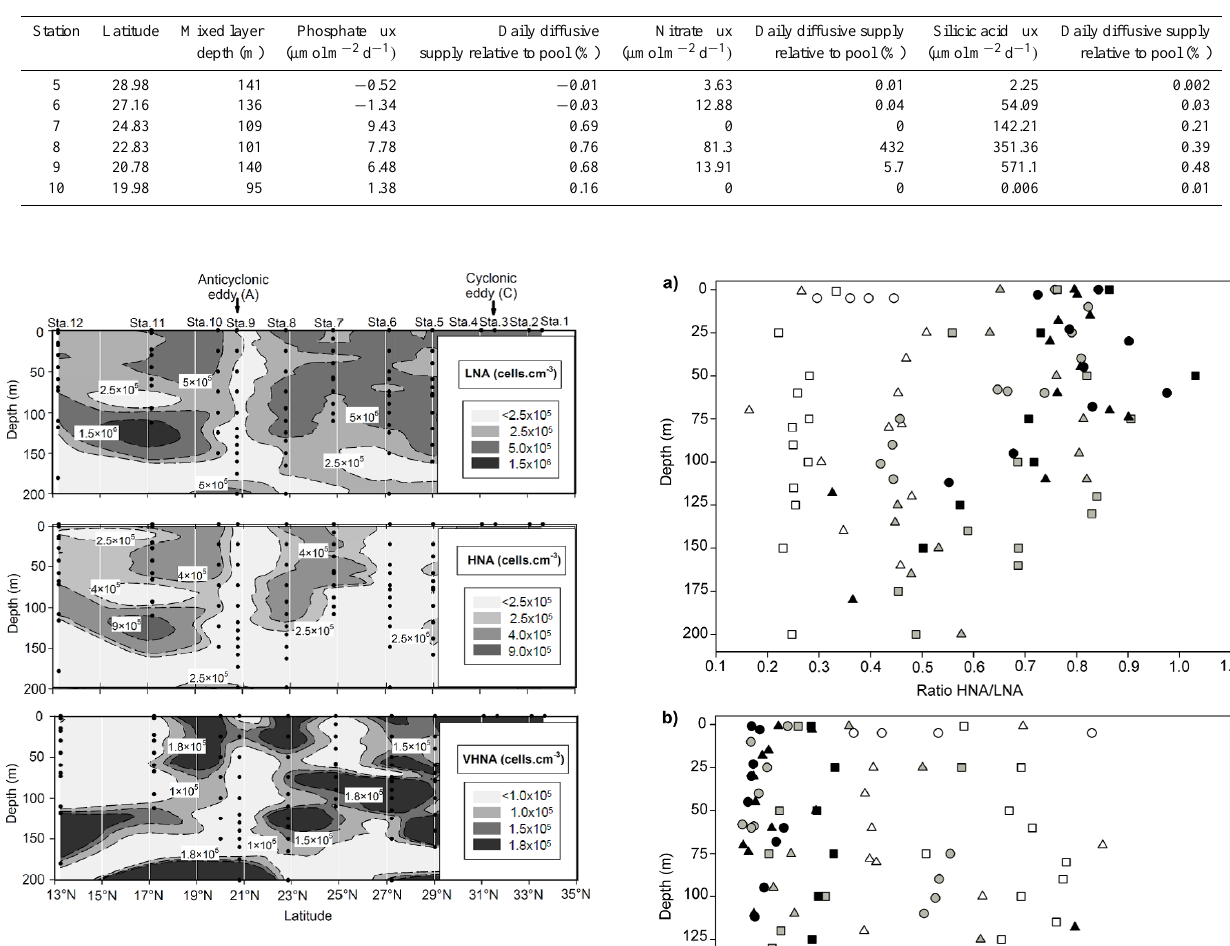
Figure 4. Vertical concentration (cellscm − 3 ) of LNA, HNA, and VHNA heterotrophic prokaryotes interpolated along the transect during the Tokyo–Palau Cruise. The black dots are the depths sam- pled.